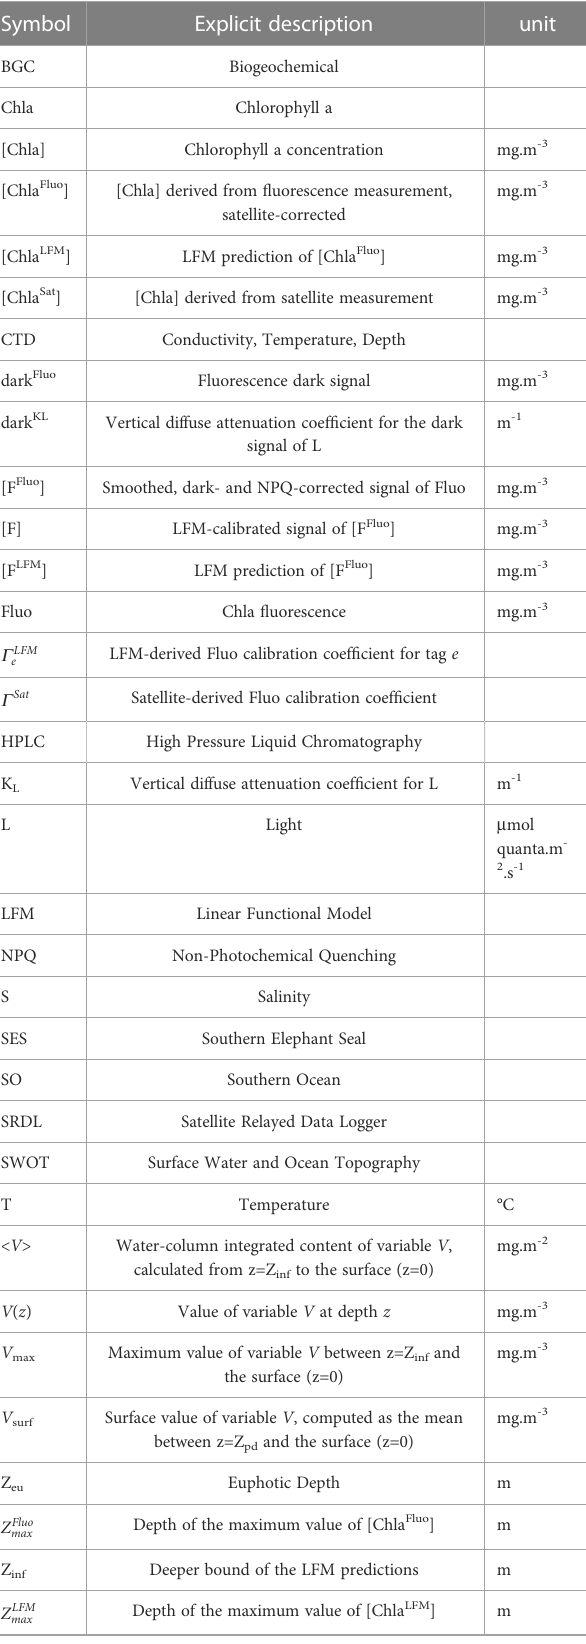
TABLE 1 Acronyms, de fi nitions and